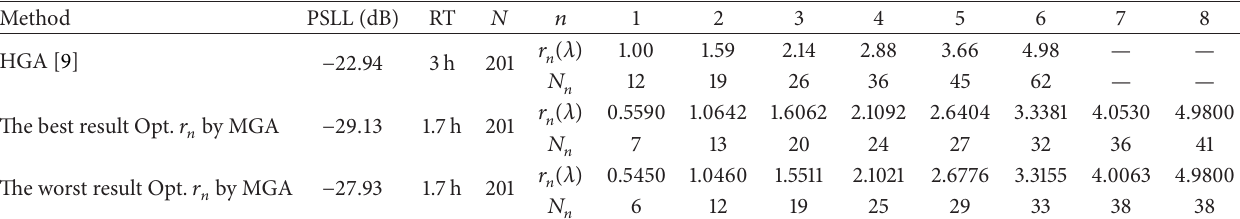
Table 1: Hybrid genetic algorithm (HGA), peak sidelobe level (PSLL), modified real genetic algorithm (MGA), number of elements ( 𝑁 ), run time (RT), ring radii ( 𝑟 𝑛 ), and number of elements in the rings ( 𝑁 𝑛 ).